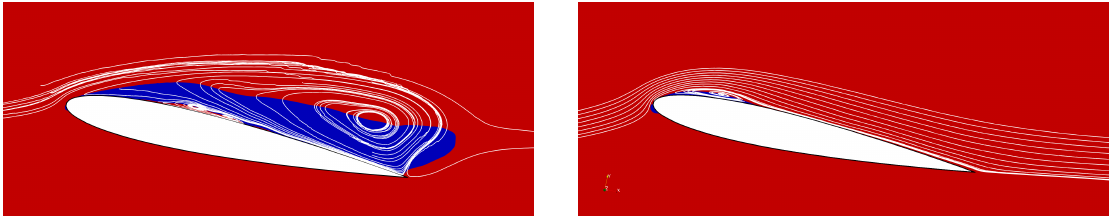
Figure 12. Streamlines over the wing in laminar ( left ) and turbulent ( right ) freestream conditions. The reverse flow is marked by a blue zone.